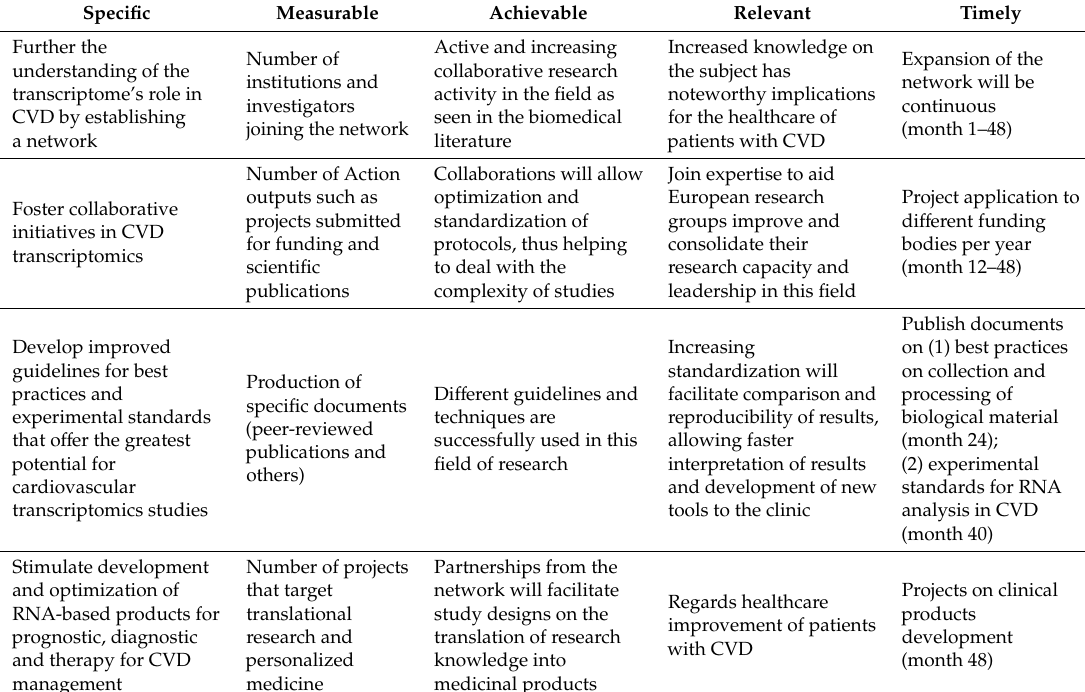
Table 1. Research objectives of